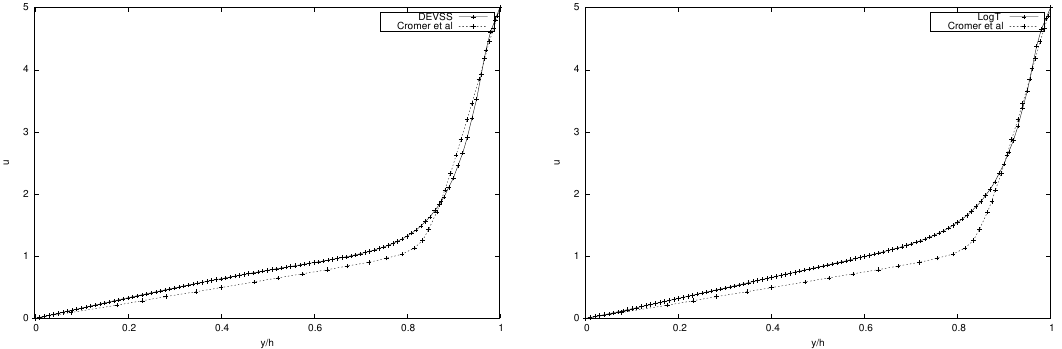
Figure 15. Velocity profile for k = 1 using the DEVSS method (LHS) and the LCR method (RHS) (compared with references